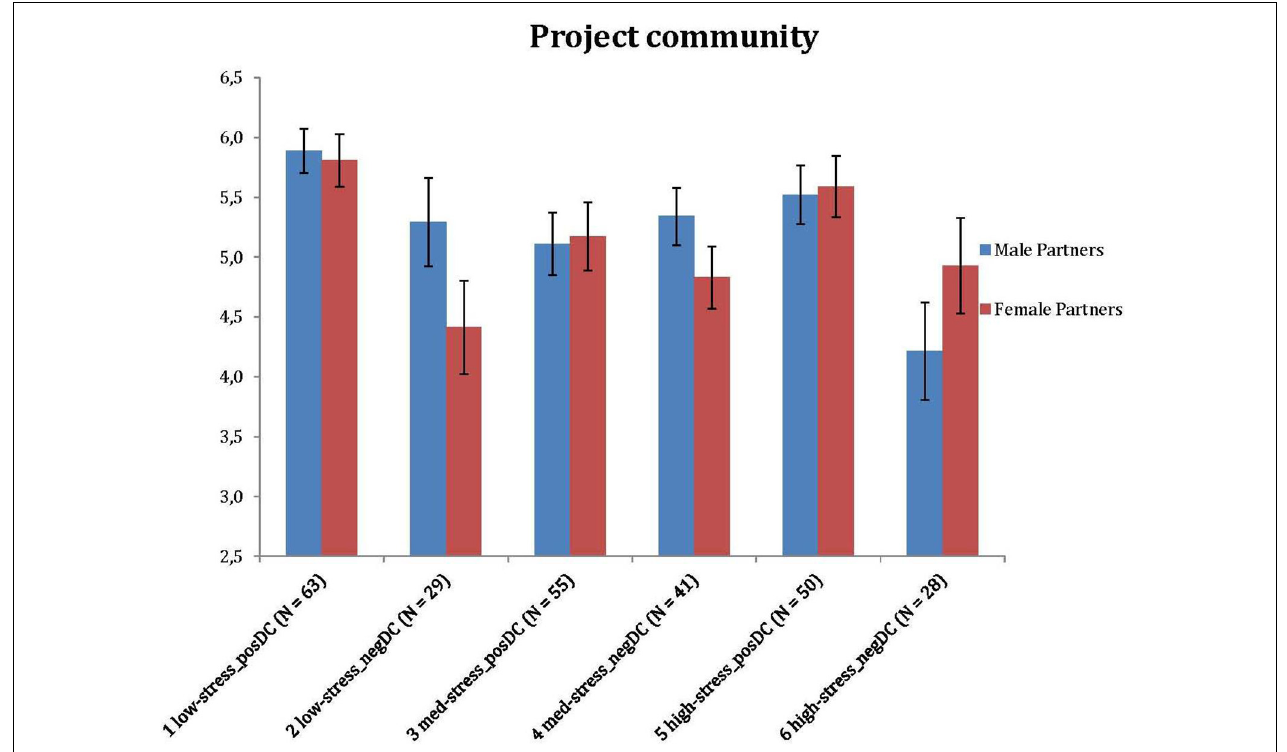
FIGURE 5 | Differences of clusters: sense of community in personal